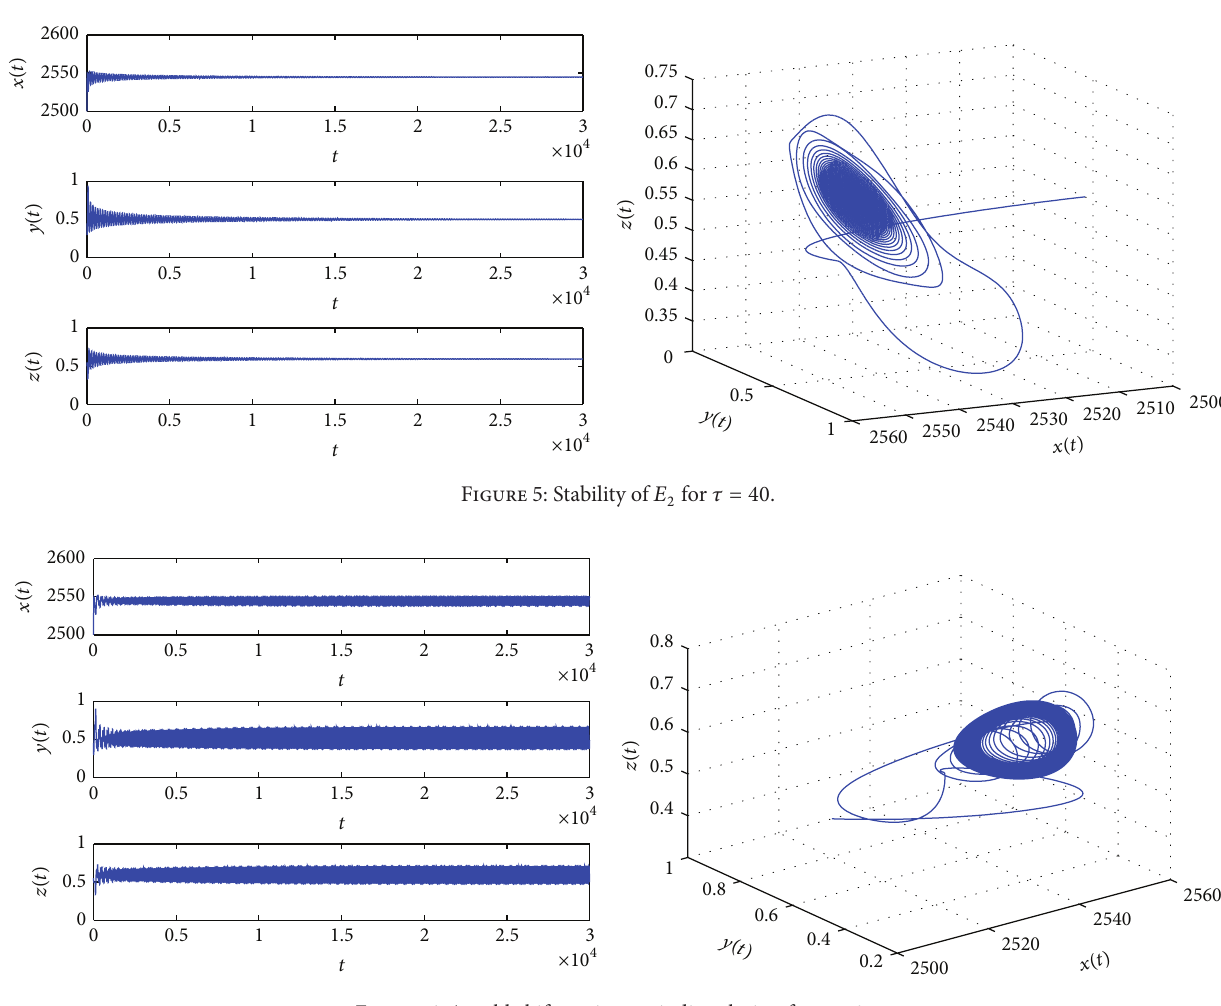
Figure 6: A stable bifurcating periodic solution for 𝜏 = 95 .